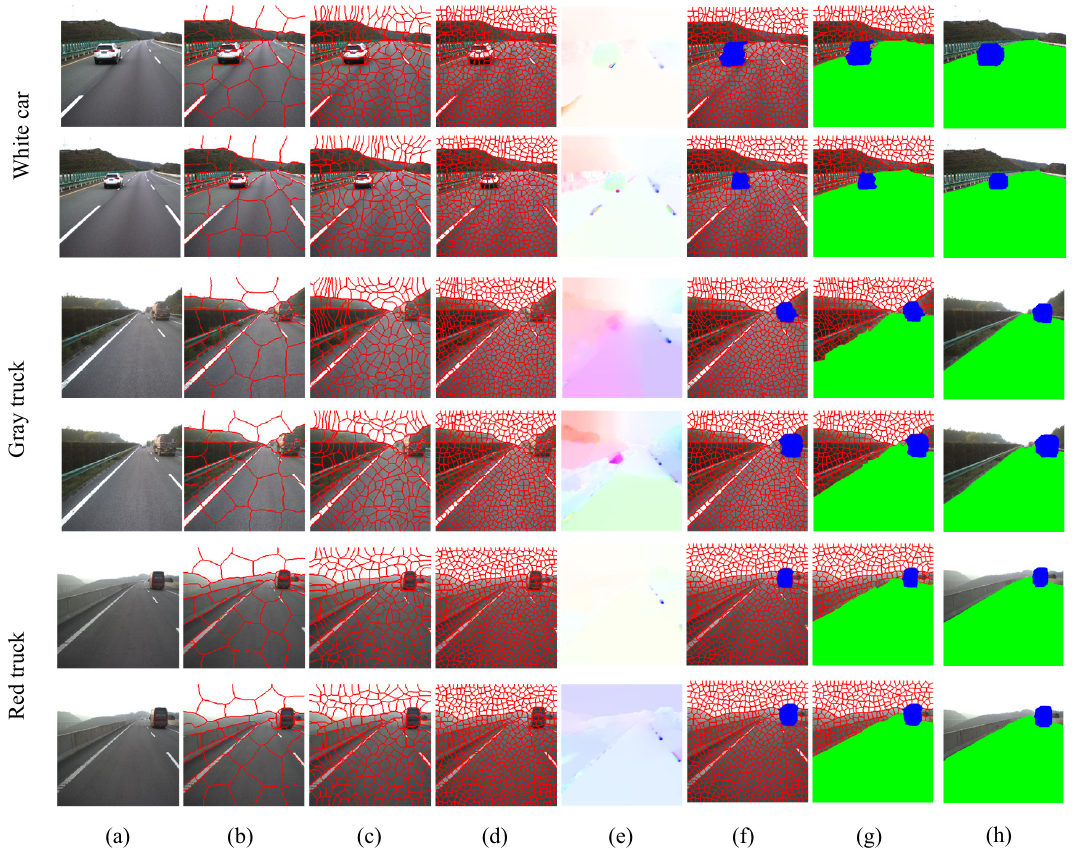
Figure 8. Region detection results based on the RW method (TSD-max dataset). ( a ) input image sequence; ( b – d ): superpixel segmentation with superpixel numbers of N = 40, N = 200, and N = 500, respectively. ( e ) optical flow map between adjacent frames; ( f ) detection of foreground regions; ( g ) detection of both foreground and road regions; ( h ) region refinement by FTC level